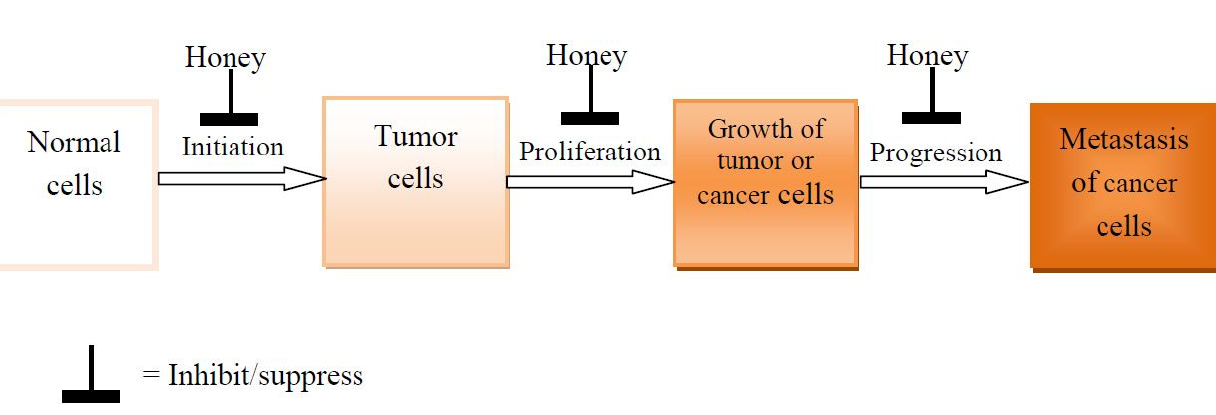
Figure 4. Honey blockage of the 3 stages of cancerogenesis.